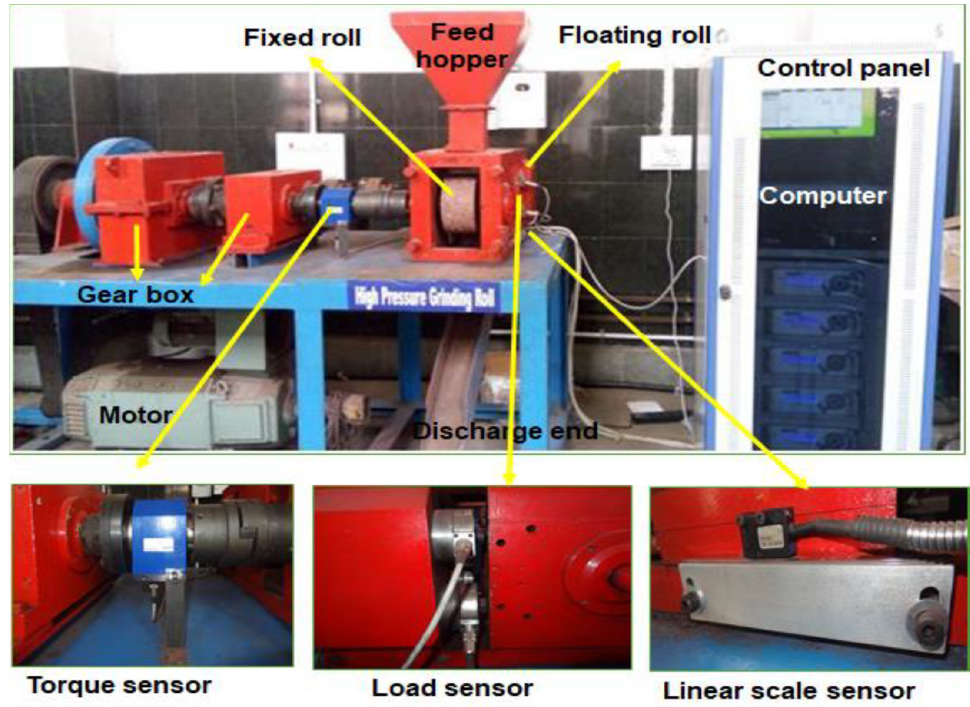
Figure 2. The instrumented laboratory HPGR along with its sensors.